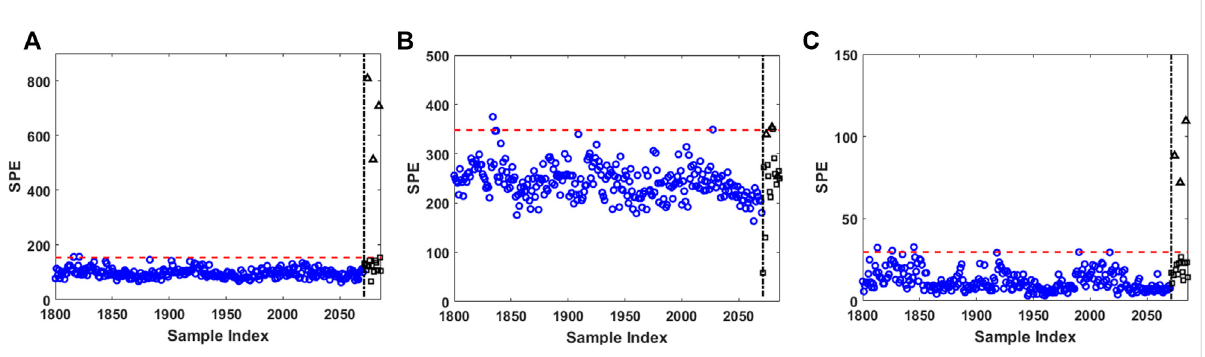
FIGURE 6 Fault scenario 5: fault detection in residual subspace (SPE) from (A) MPCA SC (B) MPCA DTW and (C) FSM. Blue circles are normal training cycles; black squares are normal testing cycles; black triangles are faulty testing cycles; horizontal red dashed lines are fault detection thresholds; vertical black dash-dotted lines separate training from testing.